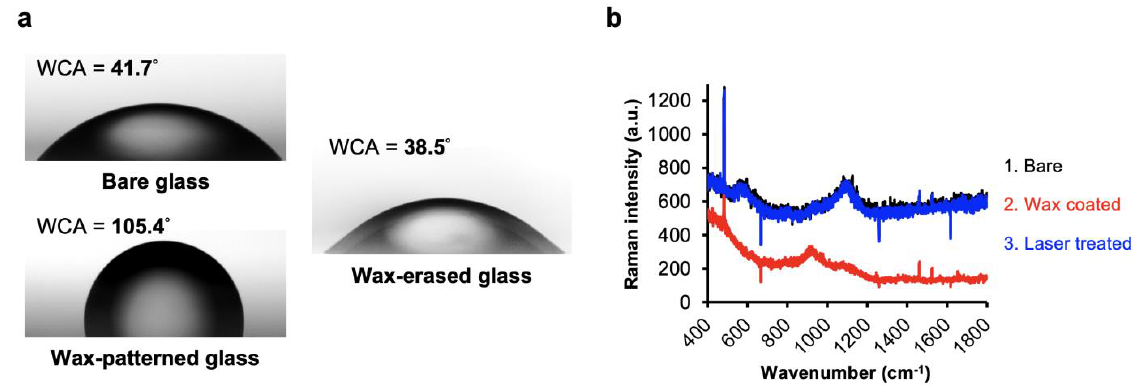
Figure 2. Complete removal of the patterned wax films by laser direct writing: ( a ) Comparison of water contact angle (WCA) measured from bare glass, wax-patterned glass, and wax-erased glass by CO 2 laser. ( b ) Raman spectra of the glass slide substrate during the three different treatments, including bare substrate (black), wax coating (red), and laser writing (blue).